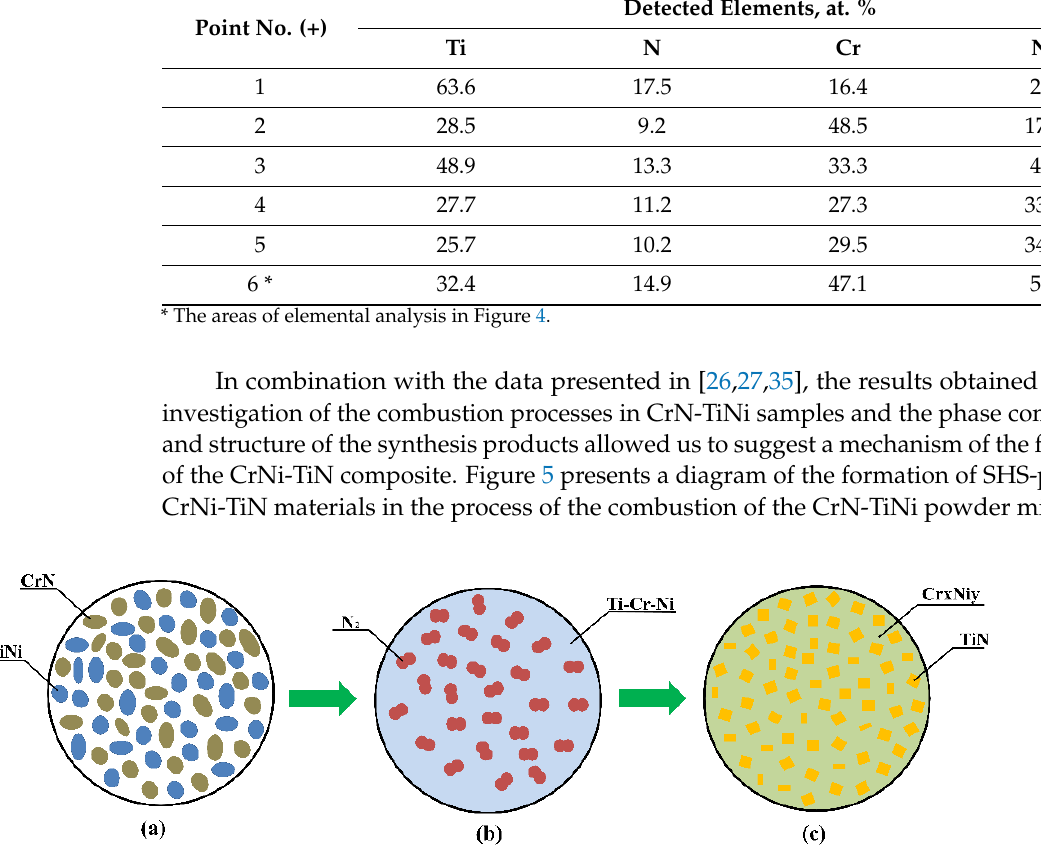
Figure 5. Diagram of the formation of SHS-produced CrNi-TiN materials in the process of the combustion of the CrN-TiNi powder mixture: ( a ) the initial components of the CrN-TiNi powder mixture, ( b ) decomposition and melting of components of the CrN-TiNi powder mixture, ( c ) the structure diagram of synthesis products CrNi-TiN